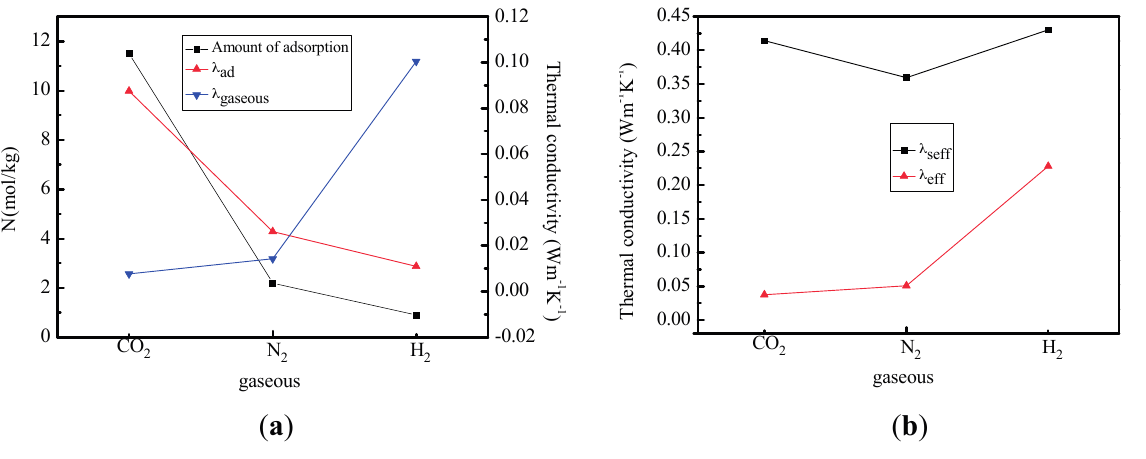
Figure 11. Amount of adsorption and thermal conductivity at 1.0 MPa and 298.15 K. ( a ) Amount of adsorption and thermal conductivity at 1.0 MPa and 298.15 K; ( b ) Effective thermal conductivity at 1.0 MPa and 298.15